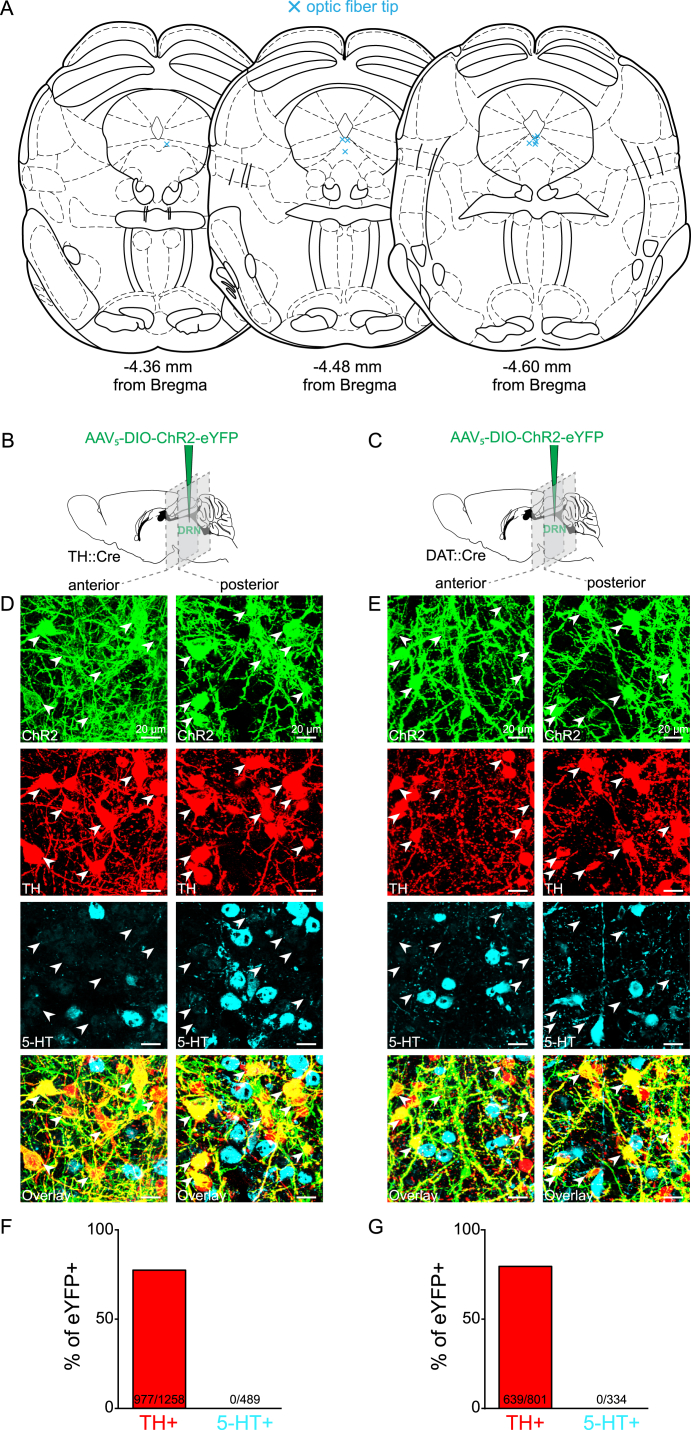
Placement of Optic Fiber in the DRN for Photometry Recordings and Immunohistochemical Characterization of ChR2-eYFP Expression in TH::Cre and DAT::Cre Mice, Related to Figures 2 and 3(A) The position of the tip of the optic fiber (blue cross) in the DRN of TH::Cre mice expressing GCaMP6m used for photometry recordings.(B) TH::Cre and (C) DAT::Cre mice received an injection of AAV5-DIO-ChR2-eYFP into the DRN and coronal brain sections were prepared after at least 4 weeks of expression.(D) High-magnification confocal images of eYFP+ neurons, within one anterior and one posterior section of the DRN, showing co-expression of eYFP with TH (red) but not 5-HT (cyan) in a TH::Cre and (E) a DAT::Cre mouse. White arrows indicate selected eYFP+/TH+ neurons.(F) The proportion of eYFP+ neurons in the DRN co-labeled with TH and 5-HT in TH::Cre and (G) DAT::Cre mice. There was no significant difference in the proportion of eYFP+ neurons co-labeled with TH in TH::Cre and DAT::Cre mice (Chi-square = 1.2931, p = 0.2555, n = 977/1258 neurons for TH::Cre, n = 639/801 neurons for DAT::Cre).